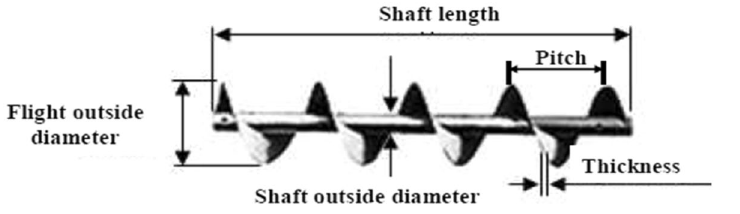
Figure 3. Components of screw